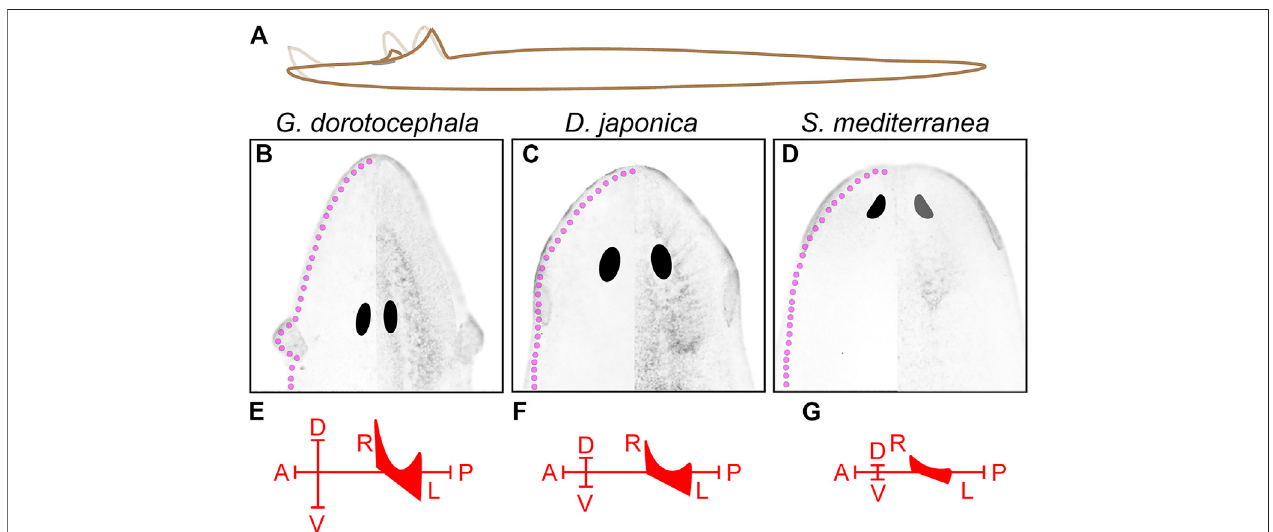
FIGURE 8 | Possible contributions to chemical sensing from three-dimensional extension of auricle architecture. (A) Illustration of observed G. dorotocephala movements depicts the possible extension of 3-dimensional range covered by the auricles and head-tip. (B – D) Image of acetylated-alpha-tubulin-labeled ciliated sensorycellsin G.dorotocephala (B) , D.japonica (C) ,and S.mediterranea (D) areshownwiththemorphologyandpositionofthecentralnervoussystemobtainedfrom DAPI-stainedsamplesissuperimposedontherighthalfofeachimage.Thehypotheticalpositionofperipheralsensorycells(magenta)basedonstudiesof Gt-wnt5 in G. tigrina (Marsal et al., 2003), and TRP family genes in D. japonica (Inoue et al., 2014) as well as S. mediterranea (Arenas et al., 2017) are drawn along the entire peripheryoftheheadofeachspecies(magenta). (E – G) Hypotheticalchemosensoryaxesestablished bythe3-dimensional distribution ofsensorycellsineachplanarian